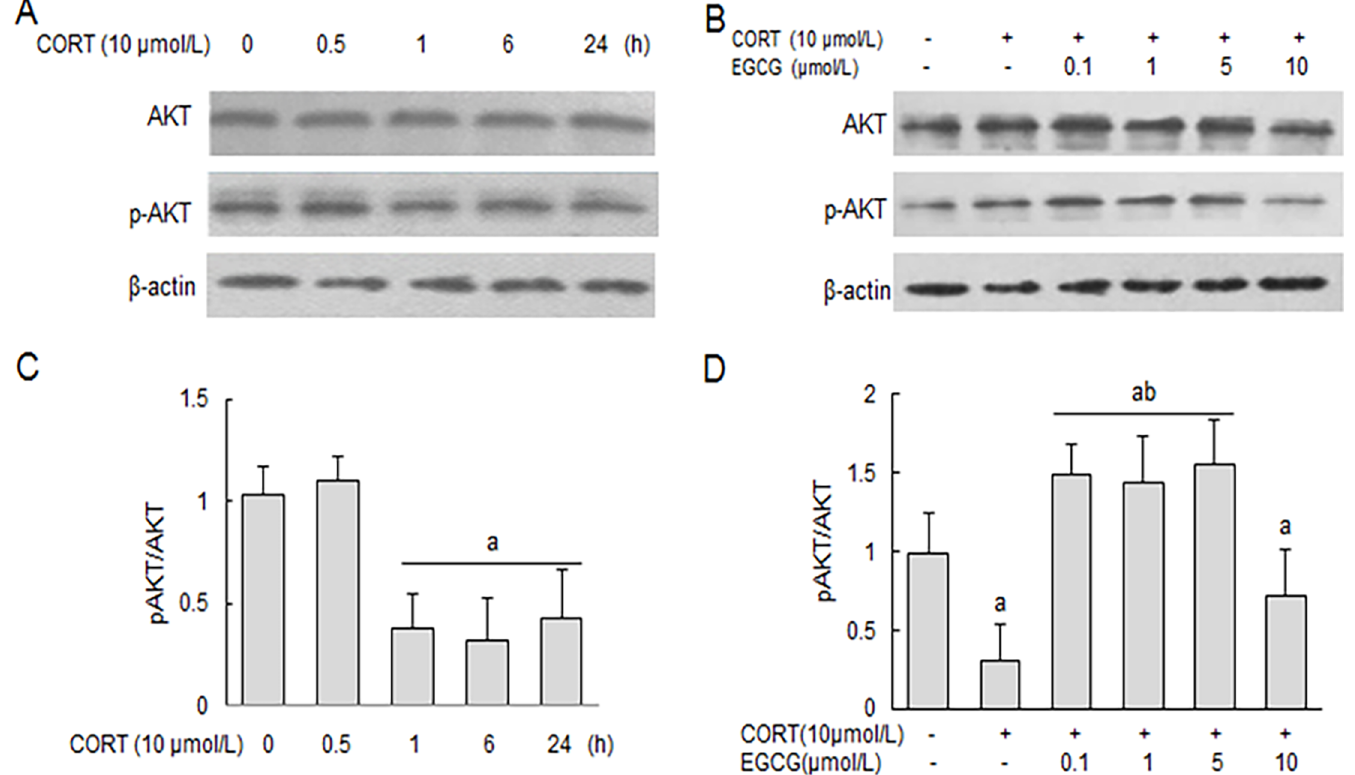
Fig 6. The effect of EGCG on CORT-induced decrease of AKT phosphorylation in primary hippocampal neuron cultures. Primary hippocampal neuron cultures were stimulated with CORT for 0, 0.5, 1, 6 and 24 h, respectively in the absence of EGCG (A), or in the presence of a pre-treatment with EGCG at indicated concentration for 2 h before CORT stimulation for 24 h (B). The cellular levels of total and phosphorylated AKT were determined by western blot analysis with reference to a house-keeping protein ( β -actin) as loading control. AKT and The relative protein levels were expressed as the relative band density of the corresponding protein (C, D). a P < 0.05 vs normal control group: b P < 0.05 vs CORT treatment group.